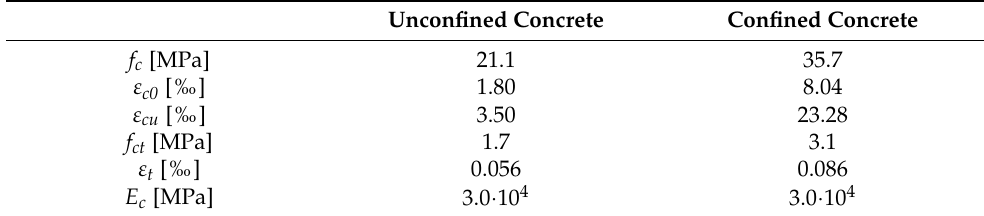
Table 3. Compressive strength ( f c ), corresponding compressive strain at f c ( ε c0 ), ultimate strain ( ε cu ), axial tensile strength ( f ct ), tensile strain at f ct ( ε t ) and elastic modulus ( E c ) of confined and unconfined concrete.